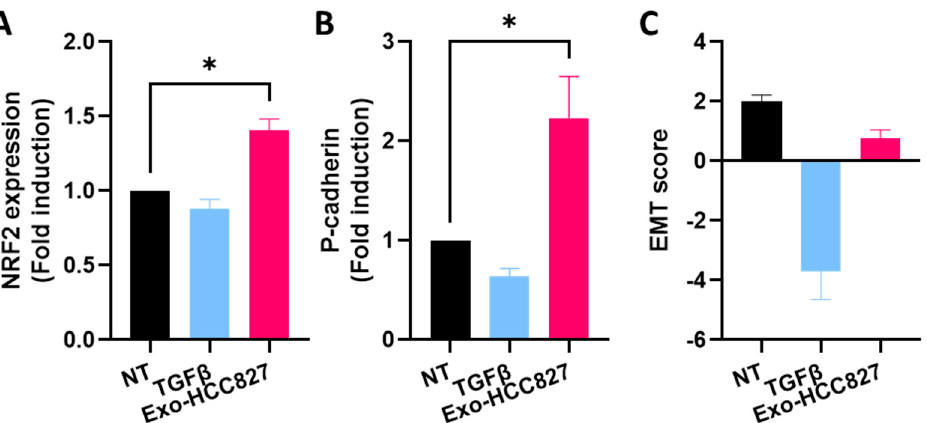
Figure 7. Exosomes from the HCC827 cell line induced hybrid EMT. Quantification analysis of NFR2 ( A ) and P-cadherin ( B ) expression obtained by RT-qPCR of protein extracts of A549 cells treated with TGF β and exosomes isolated from HCC827 supernatant (mean ± SEM, n = 3; statistical analysis was performed using unpaired t-test). Significance was set at * p < 0.05. ( C ) EMT score calculated by using RT-qPCR levels of two epithelial and three mesenchymal markers. (Chae et al., modified formula).